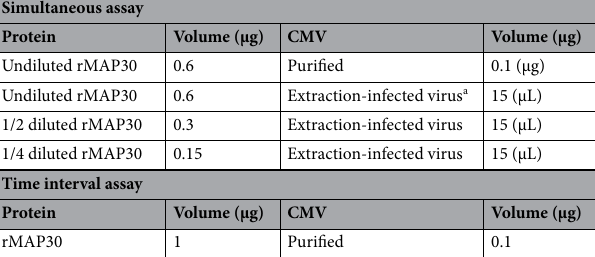
Table 4. Anti-CMV activity of MAP30. The different concentrations of purified recombinant MAP30 and the total protein extracted from transgenic lines are shown. Simultaneous assay indicates the treatments using MAP30 and CMV at the same time. Time interval assay indicates the treatments using MAP30 and CMV separately and in a period of the time. a This means the total extraction was obtained from virus infected leaves of the